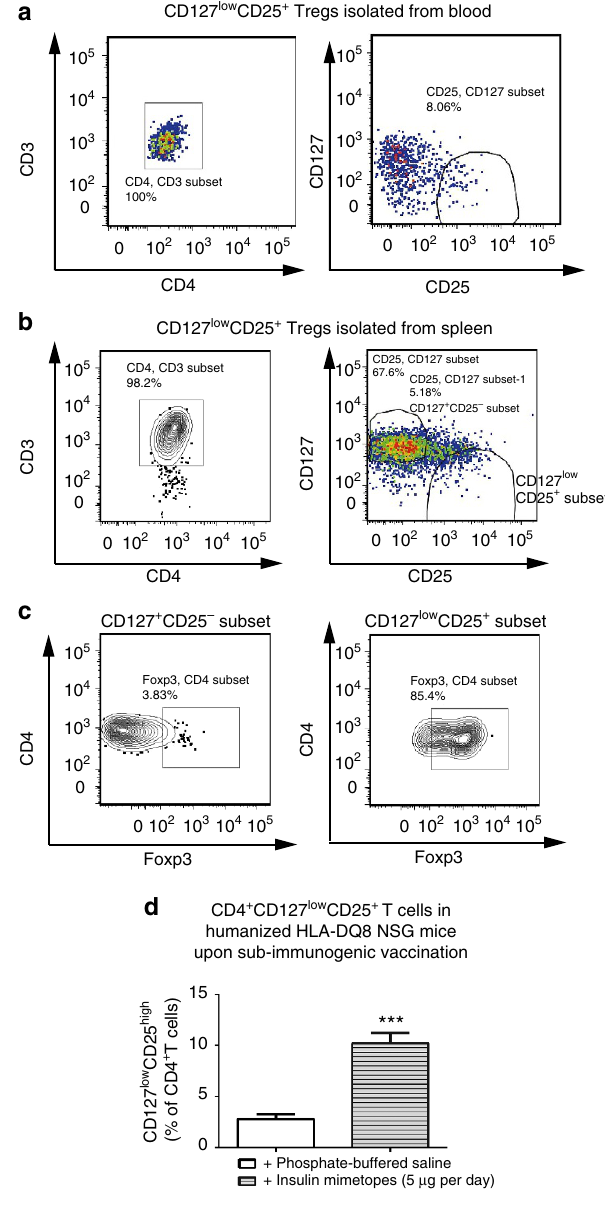
Figure 9 | Identification of CD127 low CD25 þ Tregs in humanized NSG- HLA-DQ8 mice. Human immune subsets isolated from peripheral blood or spleen purified from humanized NSG-HLA-DQ8 mice, 23 weeks post reconstitution, were first identified flow cytometrically based on human CD45 expression. Human CD4 þ CD3 þ T cells were characterized upon exclusion of dead cells and additional markers (CD8, CD11b, CD14 and CD19). ( a ) Representative set of FACS plots for the identification of CD4 þ CD3 þ CD127 low CD25 þ Tregs isolated from blood. ( b ) Representative set of FACS plots identifying CD4 þ CD3 þ CD127 low CD25 þ Tregs purified from spleen. ( c ) Verification of Treg phenotype by intracellular staining for Foxp3 in the CD127 þ CD25 - non-Treg-subset and the CD127 low CD25 þ Treg subset as identified in b (right plot). ( d ) Summary graphs for the quantification of identified CD127 low CD25 þ Tregs purified from peripheral blood and spleen upon subimmunogenic Treg induction in vivo using insulin mimetopes by osmotic mini-pumps (ins.mim.1 ¼ 14E-21G-22E; ins.mim.4 ¼ 14E-21E-22E) or control (PBS) in humanized NSG-HLA-DQ8 mice, n ¼ 8 from two independent experiments. *** P o 0.001 (Student´s t